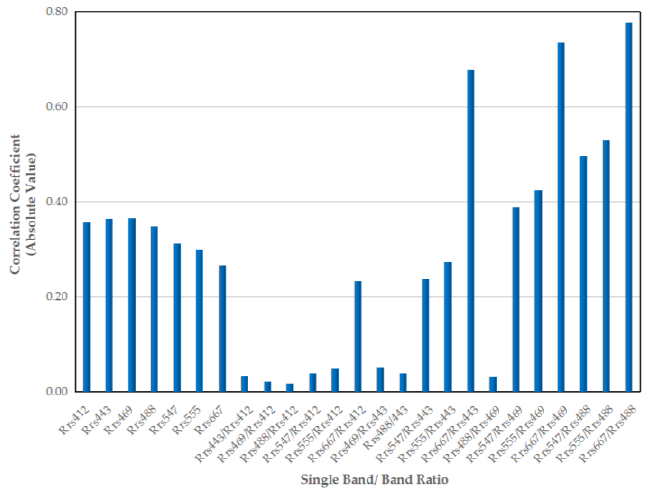
Figure 3. The correlation coefficient between MODIS\Rrs, band ratios and measured SSS.